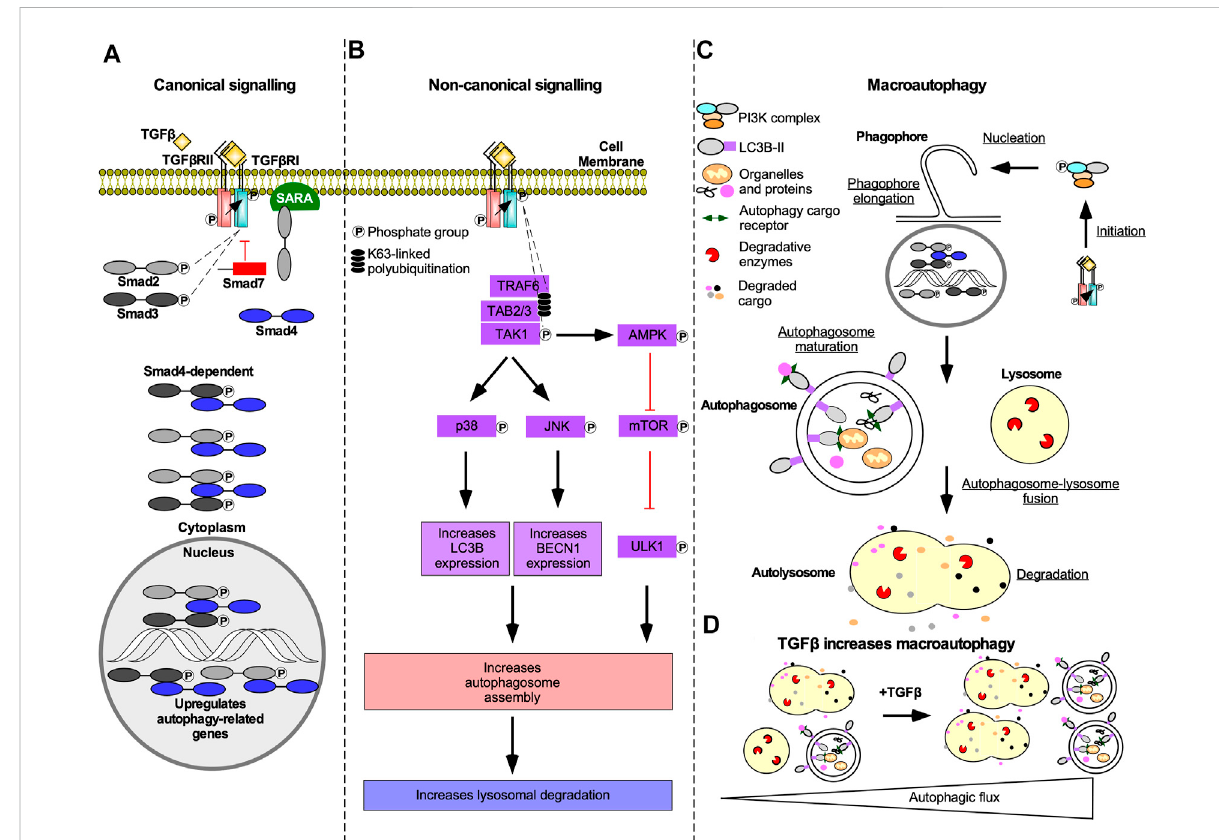
FIGURE 10 The mechanism of TGF β -dependent autophagy. (A) In Smad-dependent transforming growth factor- β (TGF β ) signalling described in Figure 2, phosphorylated receptor Smads (R-Smads) enter the nucleus with Smad4 and upregulate genes essential to autophagy. Although R-Smad transcription factors may function independently of Smad4, Smad4 knockdown blocked TGF β -dependent autophagy. (B) In Smad-independent TGF β signalling described in Figure 4, polyubiquitination of tumour necrosis factor receptor-associated factor 6 (TRAF6) recruits TGF β - activated kinase 1 (TAK1) binding proteins two and 3 (TAB2/3), which leads to TAK1 phosphorylation. Phosphorylated TAK1 activates p38 mitogen- activated protein kinase (p38) and c-Jun amino-terminal kinase (JNK) that phosphorylate several transcription factors that upregulate microtubule- associated protein light chain 3B (LC3B) and beclin1 (BECN1) expression, respectively. TAK1 also phosphorylates 5 ’ adenosine monophosphate- activatedproteinkinase(AMPK),whichisan inhibitorofan autophagysuppressorcalledmechanistictarget